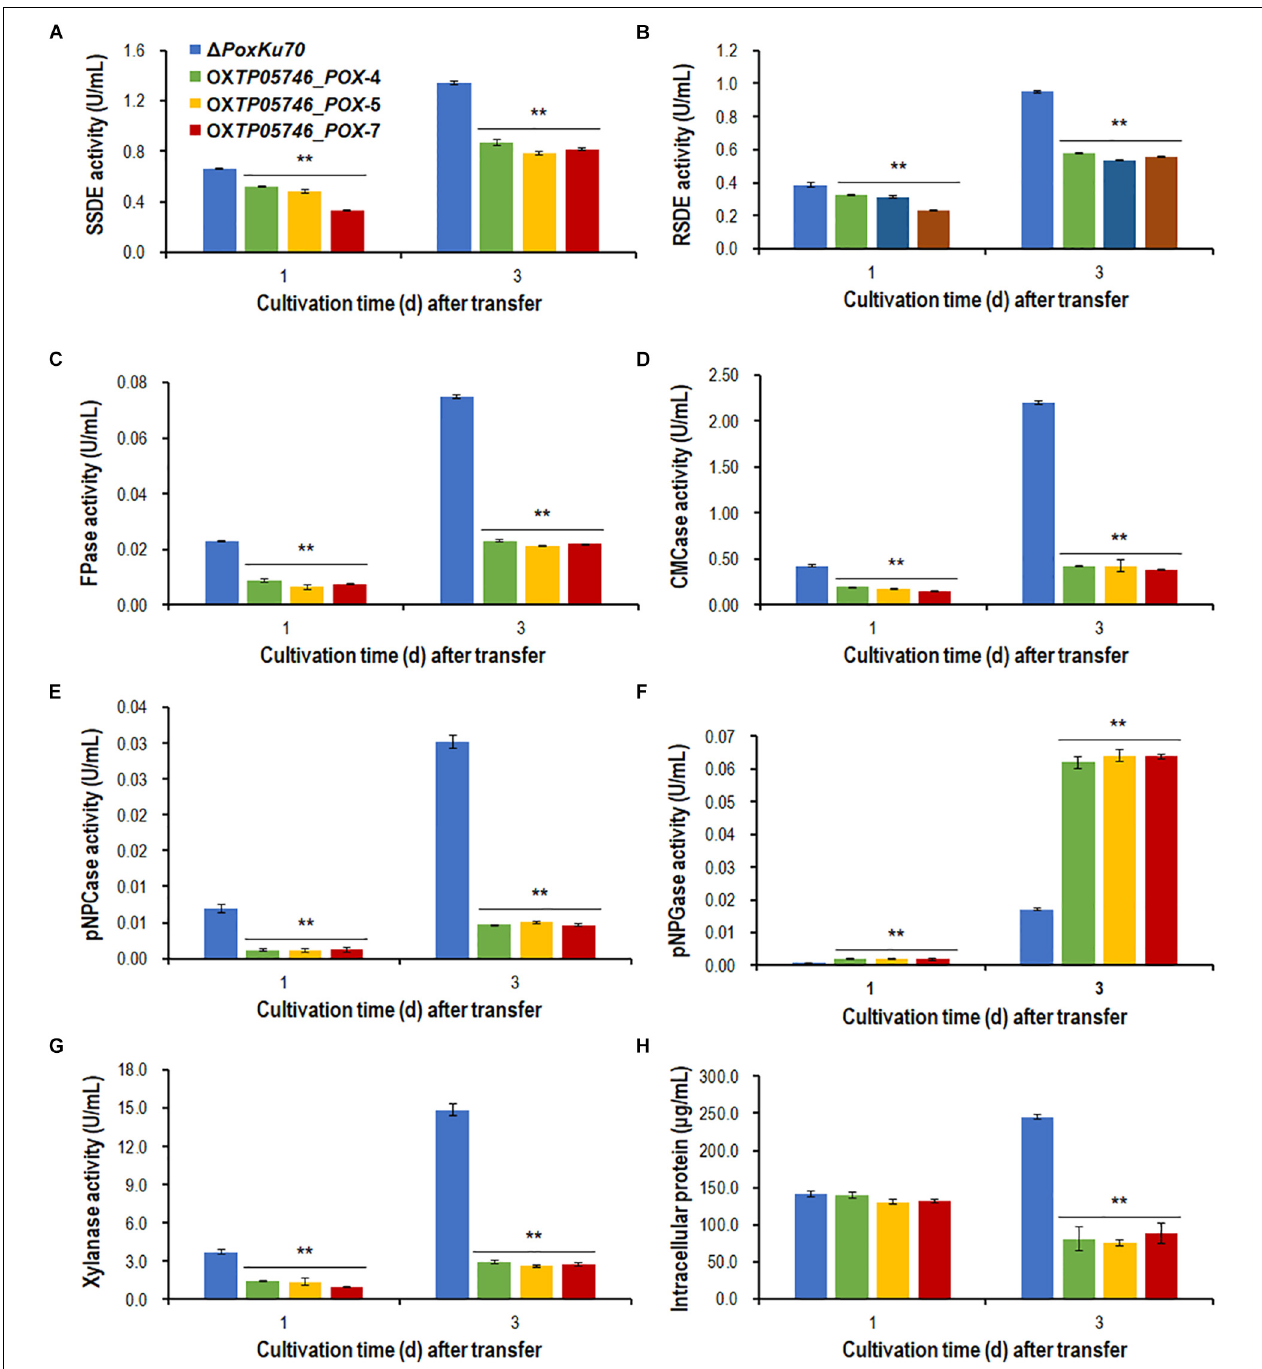
FIGURE 10 | Plant-biomass-degrading enzymes production by overexpression strain OX TP05746_POX and the parental strain (cid:49) PoxKu70 . Crude extracts were produced from Penicillium oxalicum strains cultured after a transfer from glucose medium to Avicel medium for 1–3 days. (A) SSDE production. (B) RSDE production. (C) FPase production. (D) CMCase production. (E) pNPCase production. (F) pNPGase production. (G) Xylanase production. (H) intracellular protein. All experiments were performed independently for three biological replicates. Each data point is mean ± SD. ∗∗ p ≤ 0.01 indicates differences between the deletion mutant (cid:49) TP05746 and the parental strain (cid:49) TpKu70 by Student’s t test. PBDE, plant-biomass-degrading enzyme; SSDE, soluble-starch-degrading enzyme; SCS, soluble corn starch; RSDE, raw-starch-degrading enzyme; FPase, filter paper cellulase; CMCase, carboxymethylcellulase; pNPCase, p -nitrophenyl- β -cellobiosidase; pNPGase, p -nitrophenyl- β -glucopyranosidase.